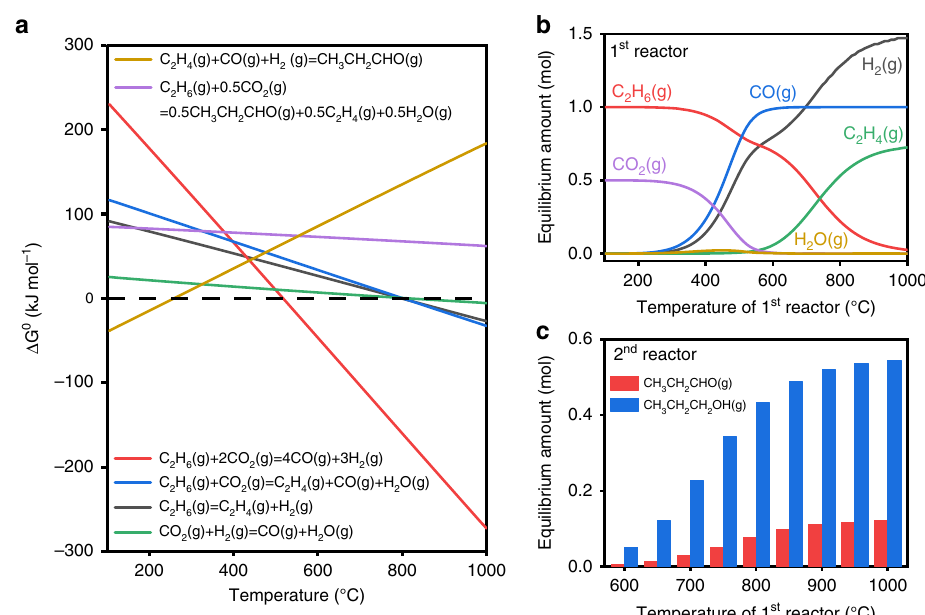
Fig. 2 Thermodynamic analyses of the proposed reaction strategy at the atmospheric pressure. a Diagram of standard Gibbs free energy change ( Δ G 0 ) of involving reactions along with temperature. b Equilibrium species distribution as a function of temperature within the fi rst reactor (feed ratio of C 2 H 6 / CO 2 = 1 mol/0.5mol). c Equilibrium amount of C3 oxygenates (propanal and 1-propanol) formed at 200 °C within the second reactor using the products of the fi rst reactor, which is maintained within the temperature range of 600 – 1000 °C. All the thermodynamics were calculated with HSC Chemistry